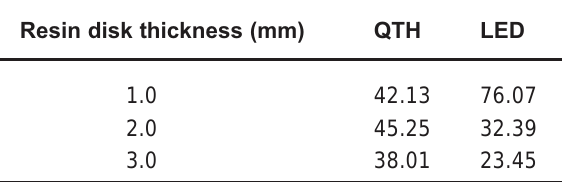
Table 3- Bottom-to-top surface microhardness ratio Resin disk thickness (mm)